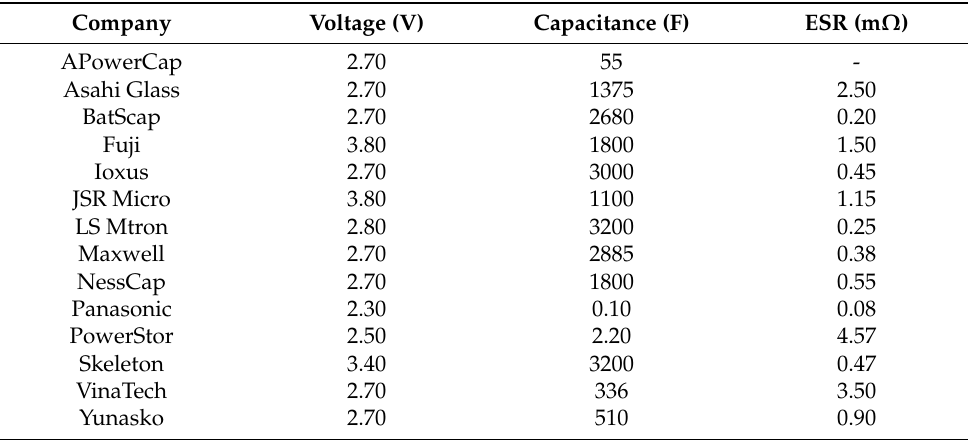
Table 2. Commercially available SCs and their